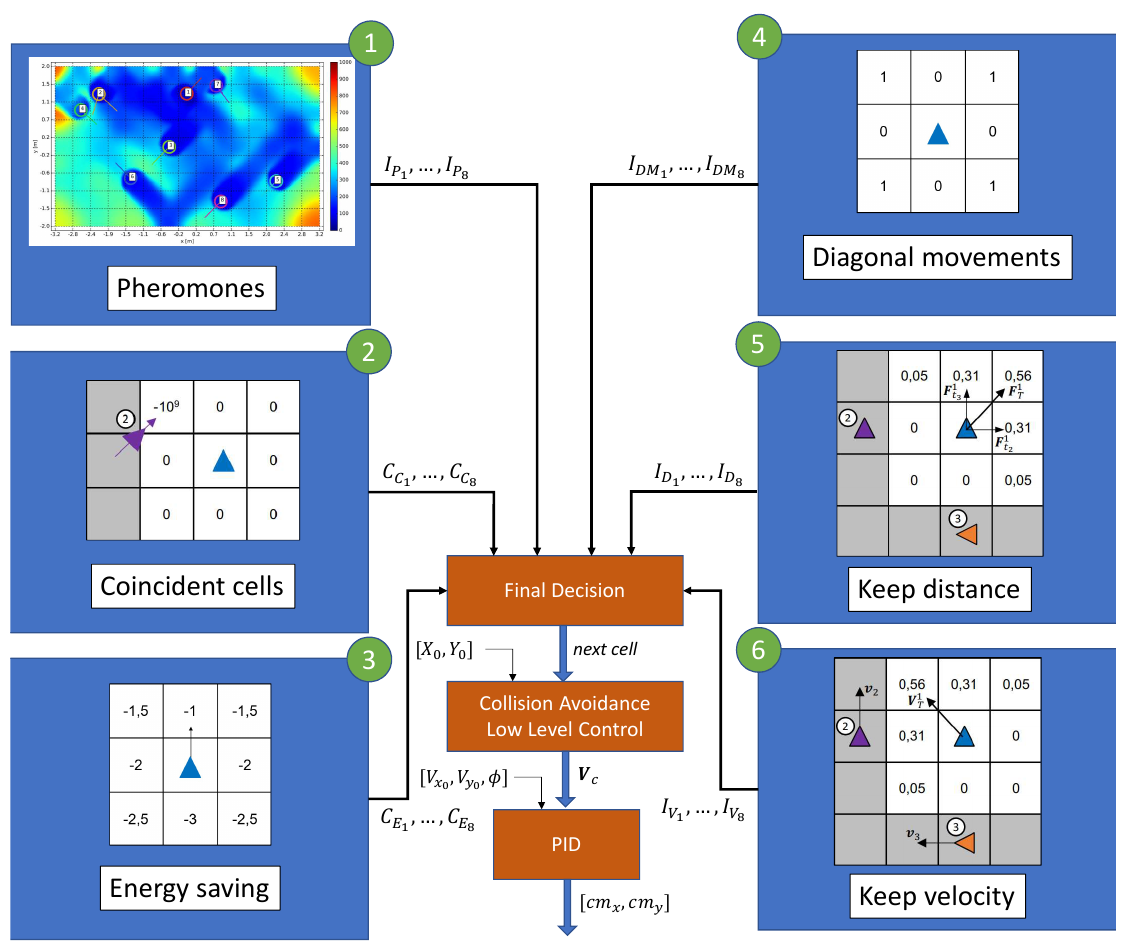
Figure 2. Scheme of the complete control algorithm of the agents. There are 6 behaviors: pheromones-based (1), coincidence goal cells avoidance (2), energy saving (3), diagonal movement